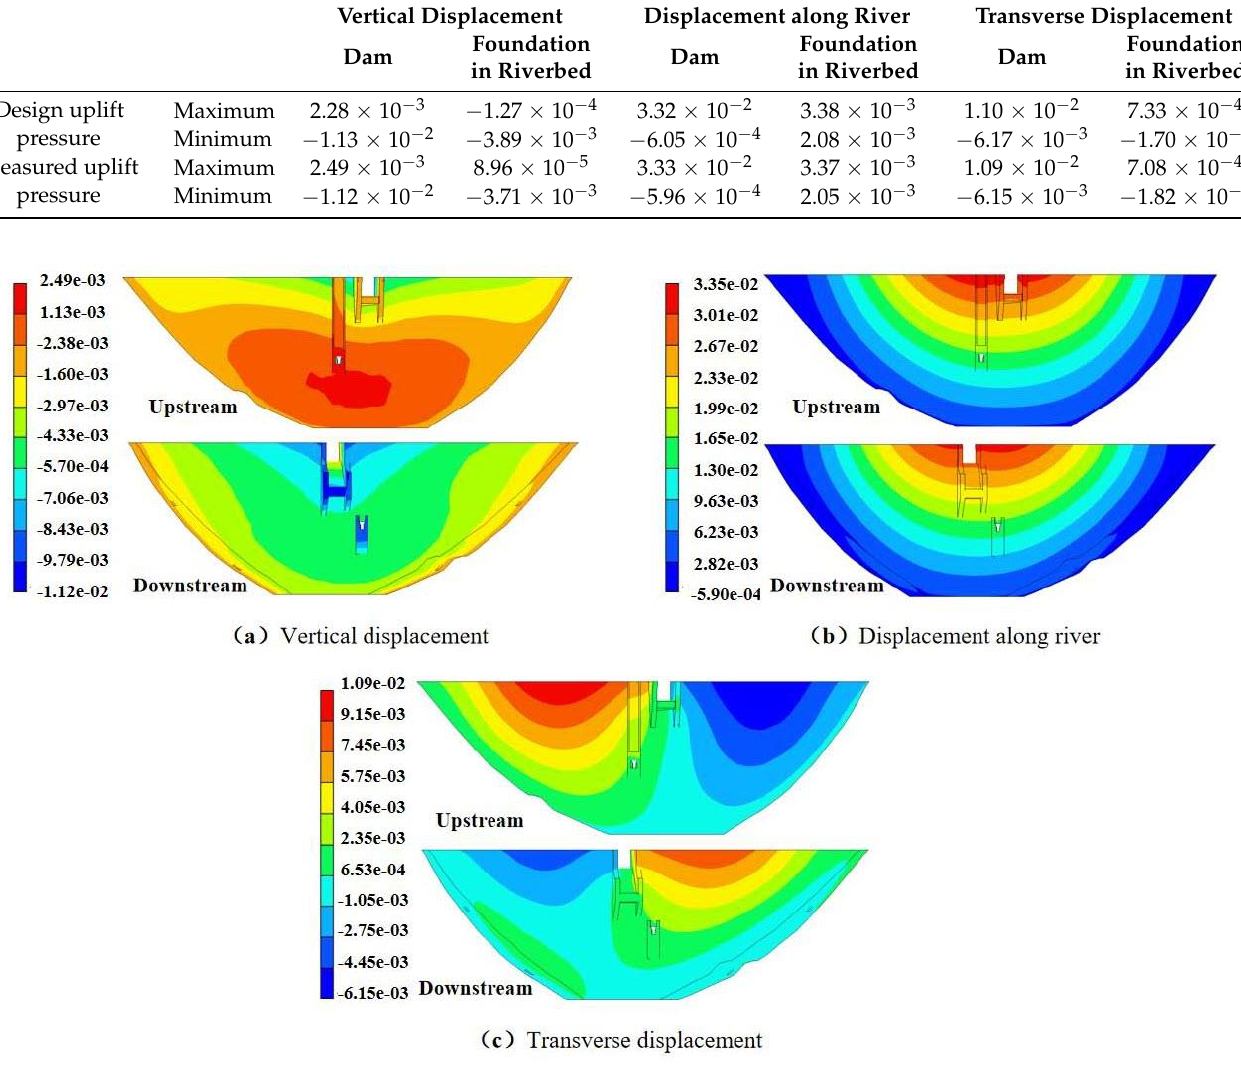
Table 4. Displacement under design and measured uplift pressure (m).